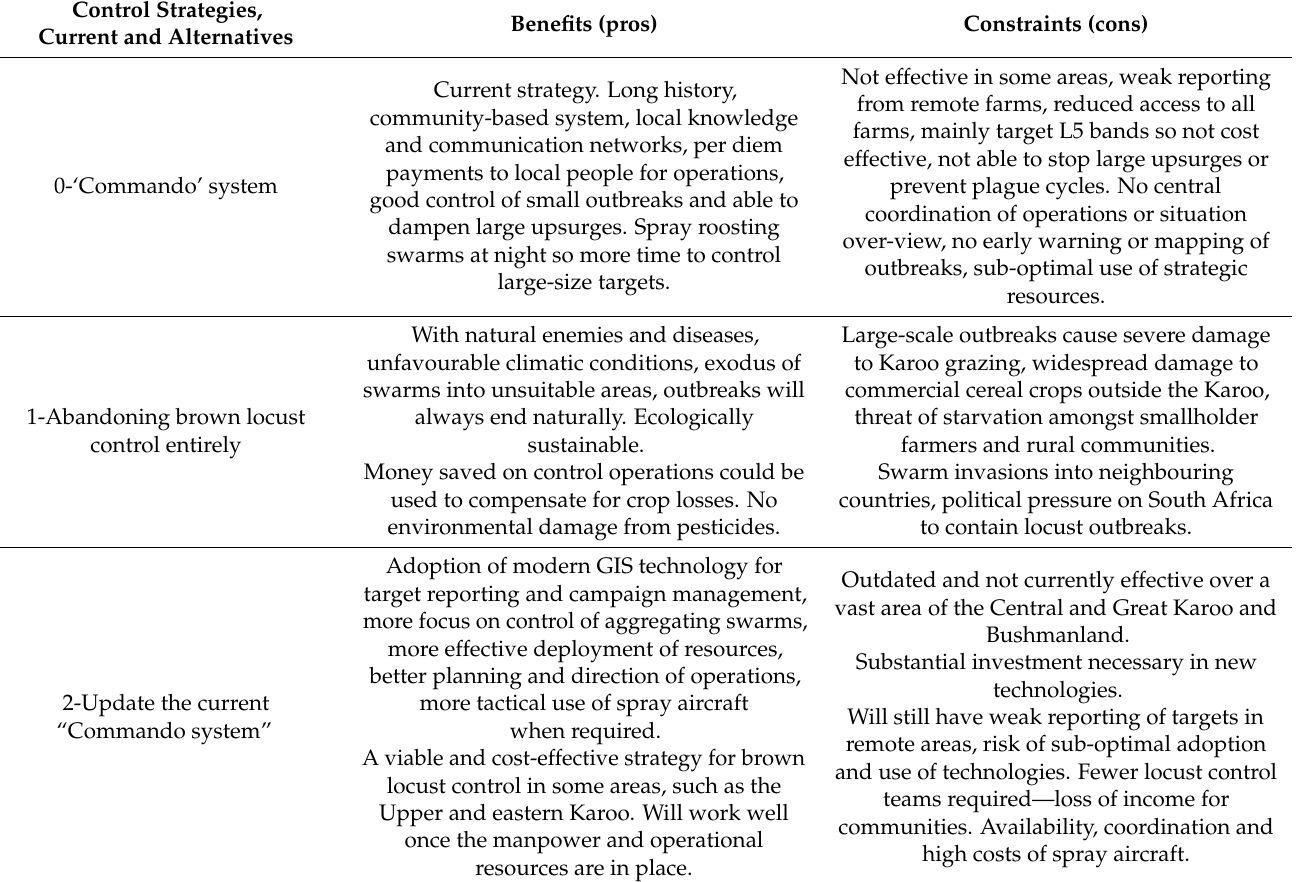
Table 3. Comparison of current and alternative strategies to manage the brown